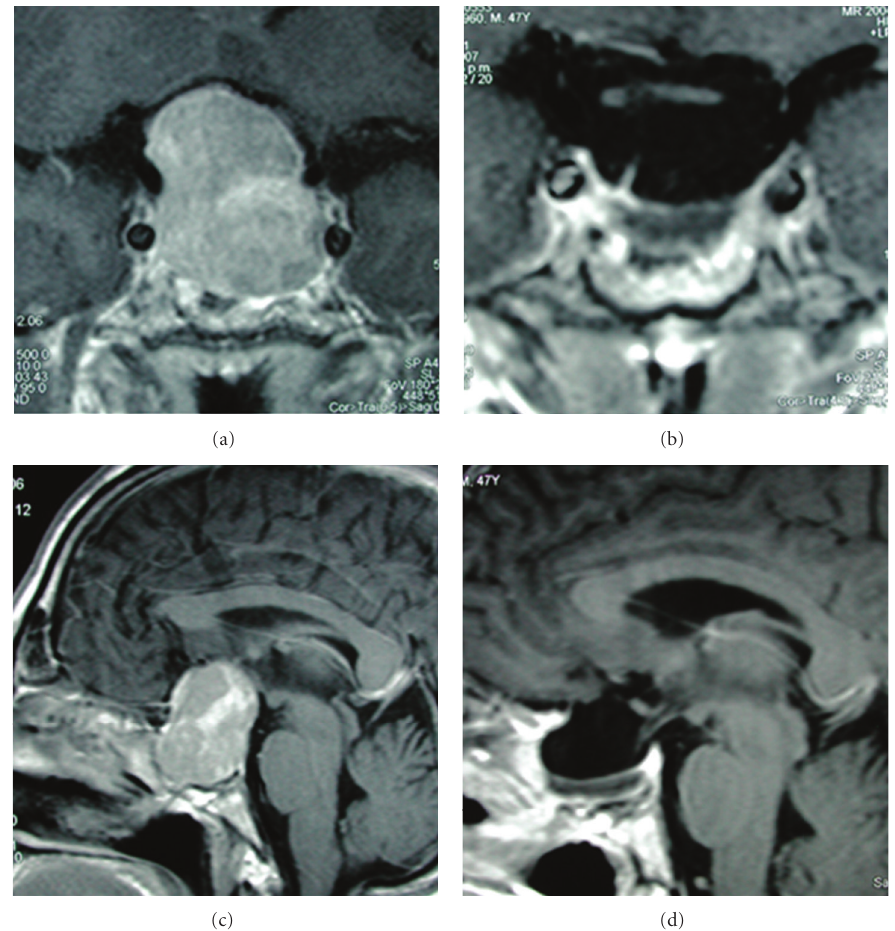
Figure 3: Large pituitary adenoma that presents a uniform suprasellar growth. Macroscopic total removal of this tumor could be obtained through a TS approach. (a, c) Preoperative imaging (upper coronal and lower sagittal). (b, d) Postoperative result in the same projections.